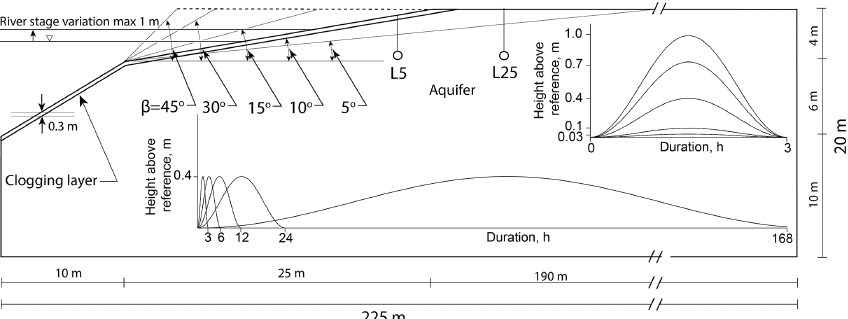
Figure 4. Graphical summary of modelling scenarios for varying river bank slope, wave duration and amplitude. For hydraulic conductivity scenarios, see text.